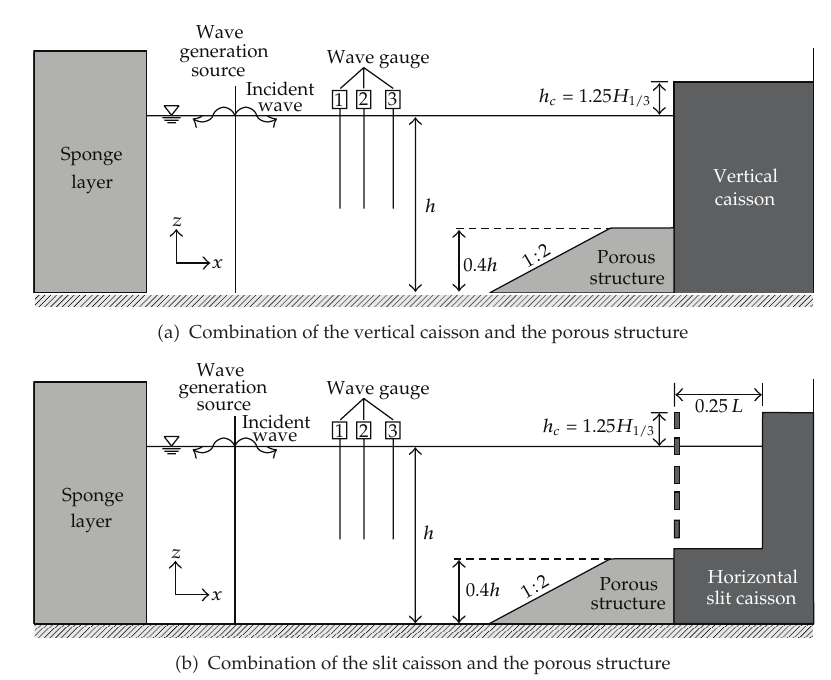
Figure 1: Schematic diagram of the numerical wave